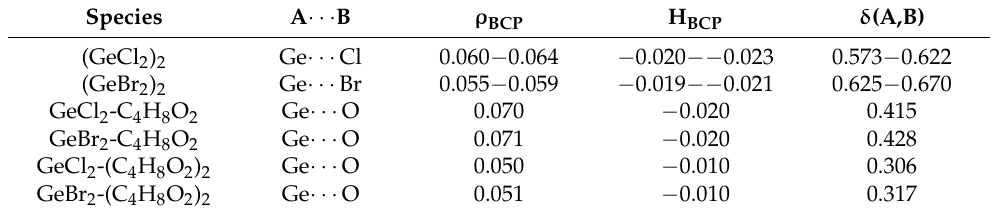
Table 4. The QTAIM characteristics (in au) of bond critical points—BCPs (corresponding bond paths are indicated); ρ BCP —electron density at BCP, H BCP —the total electron energy density at BCP, δ (A,B)—delocalization index corresponding to A · · · B bond